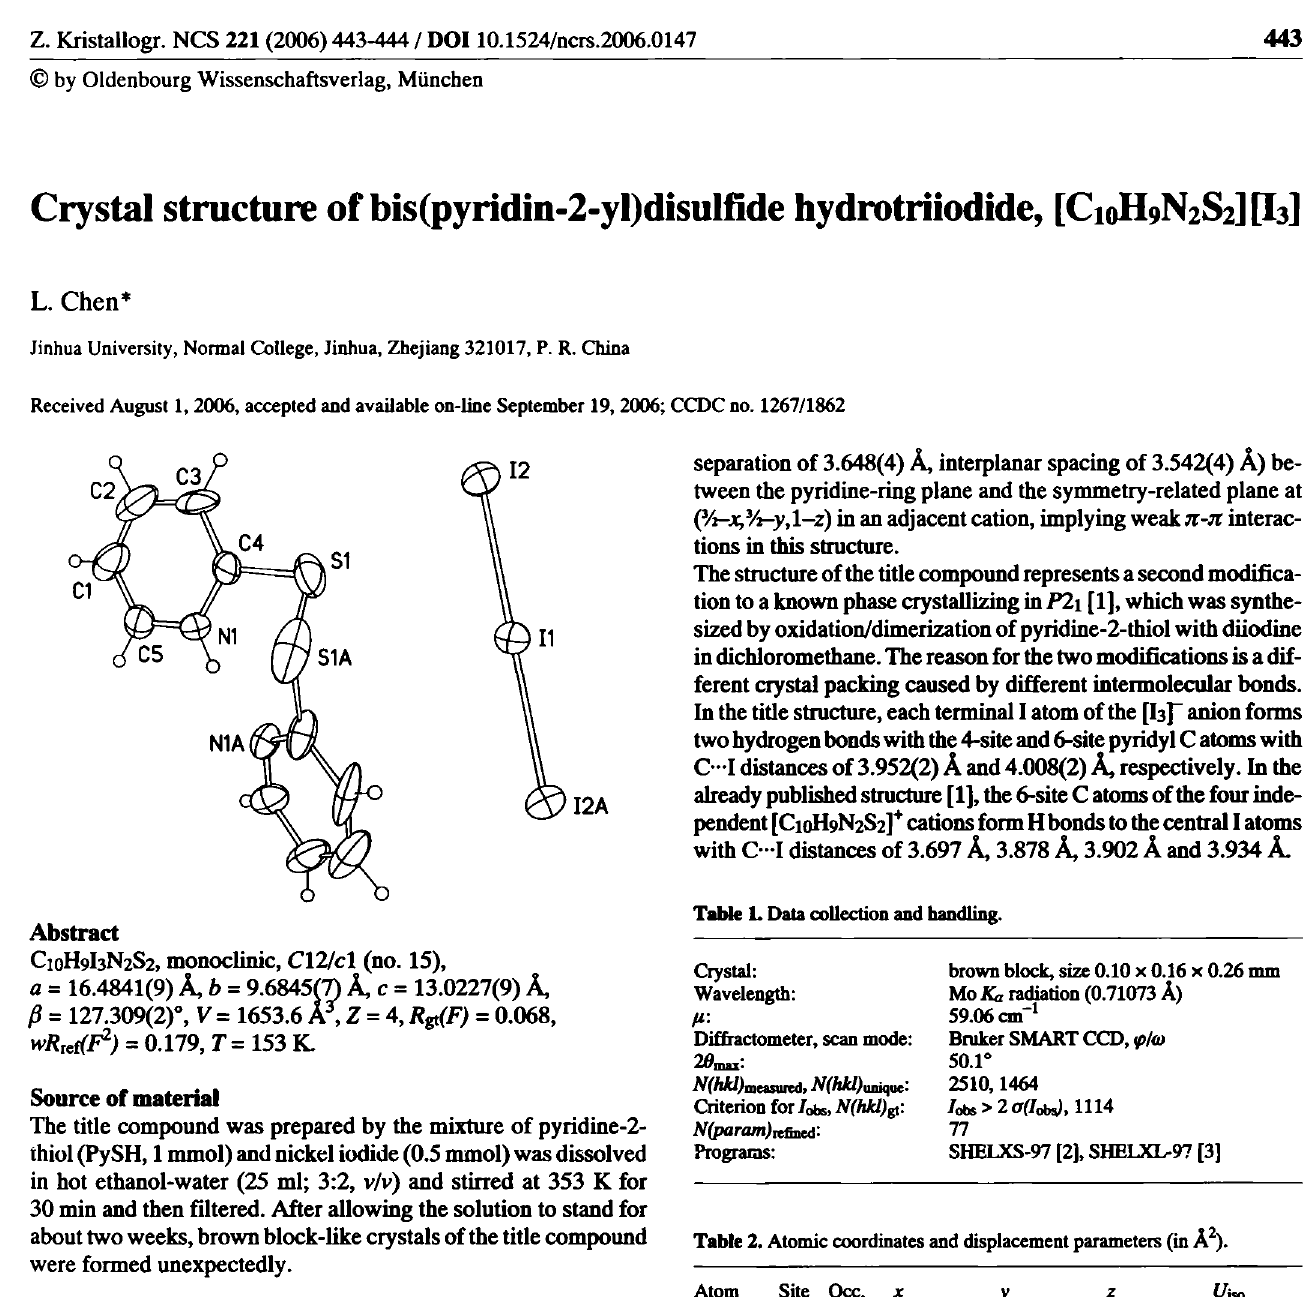
Table 2. Atomic coordinates and displacement parameters (in A 2